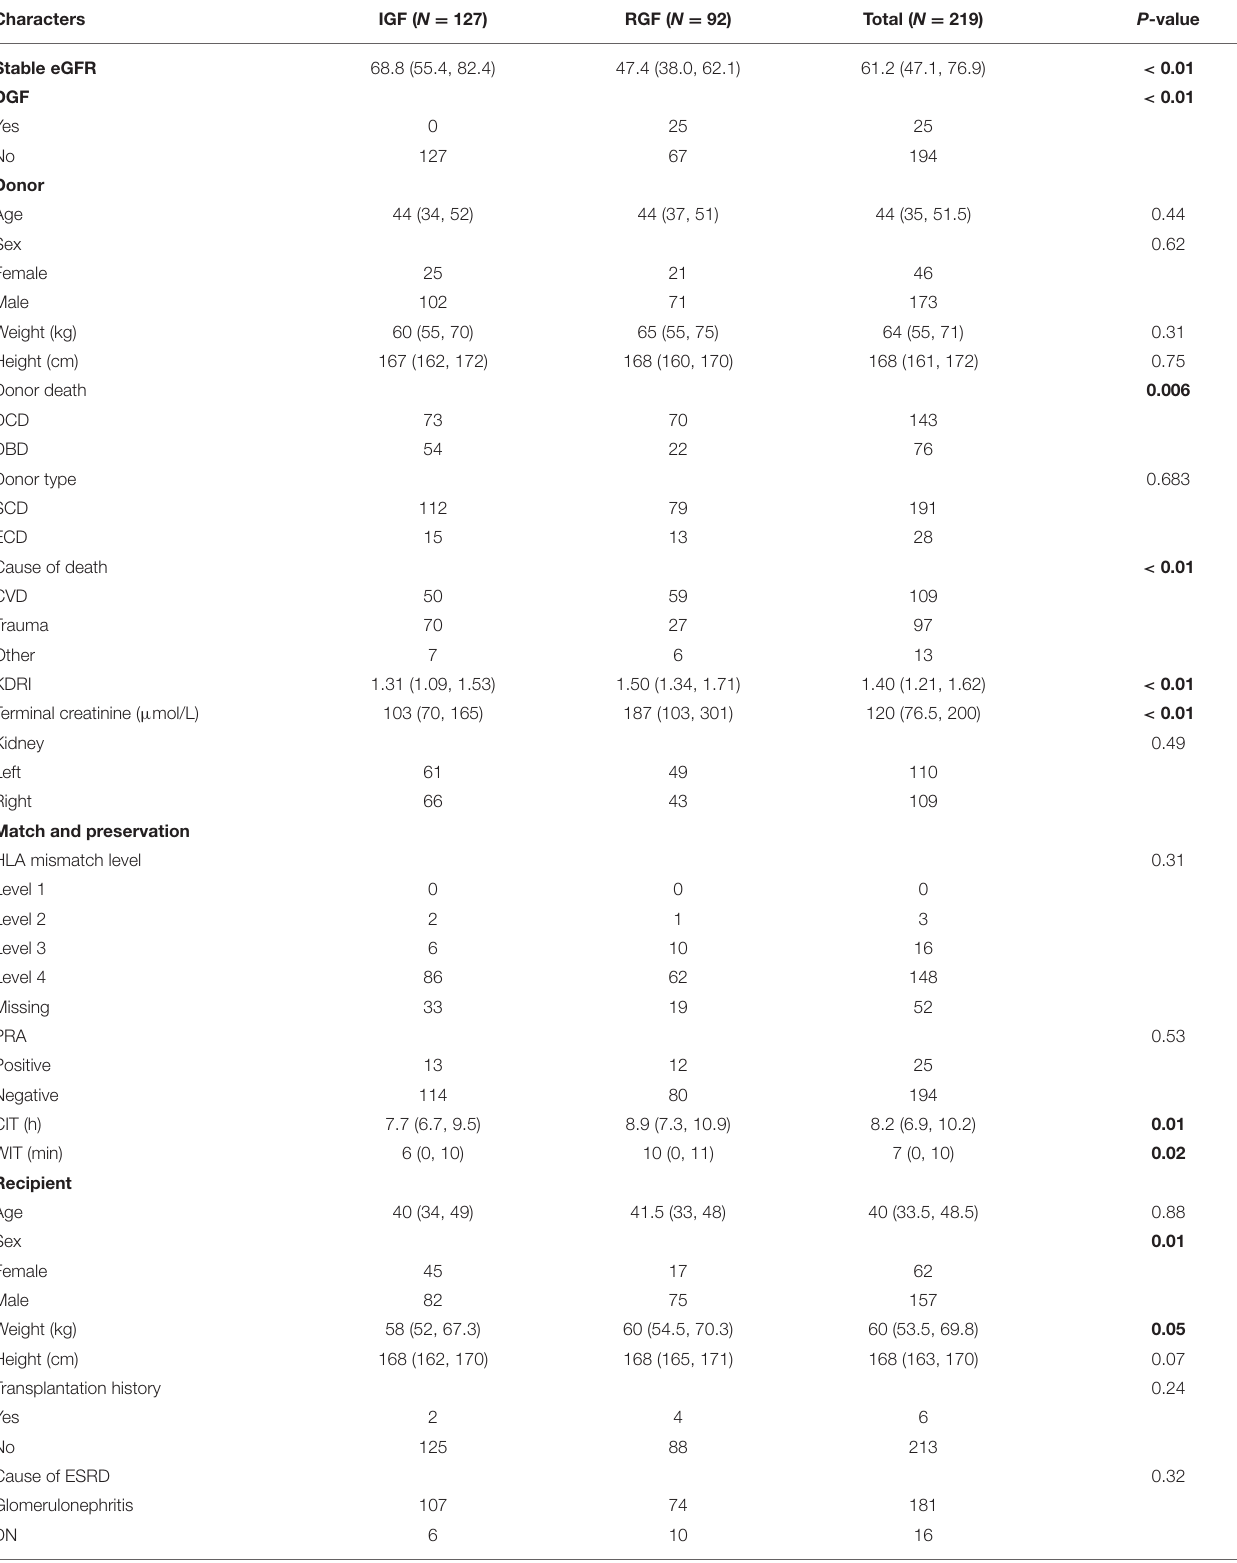
TABLE 1 | Distributions of the patient baseline